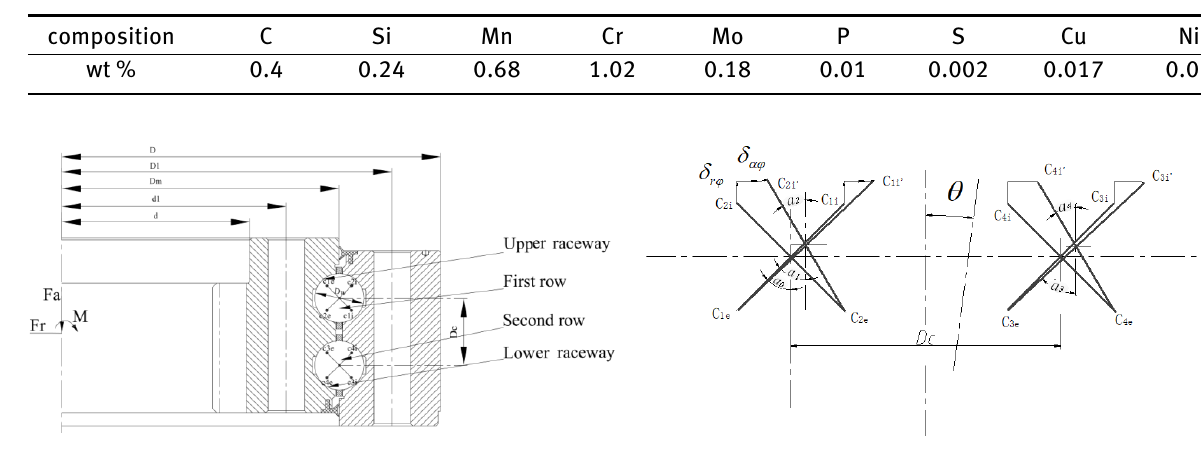
Table 2: Chemical compositions of 42CrMo4 steel